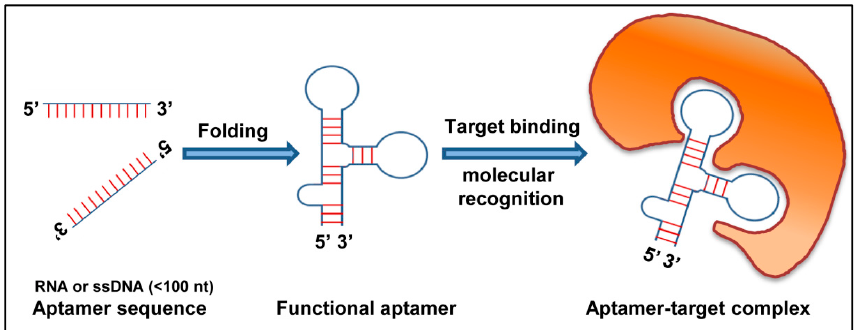
Figure 4. Schematic representation of action of aptamer: An aptamer folds into a three-dimensional structure. The functional aptamer then recognizes and binds to its target molecule resulting in a stable aptamer-target complex.